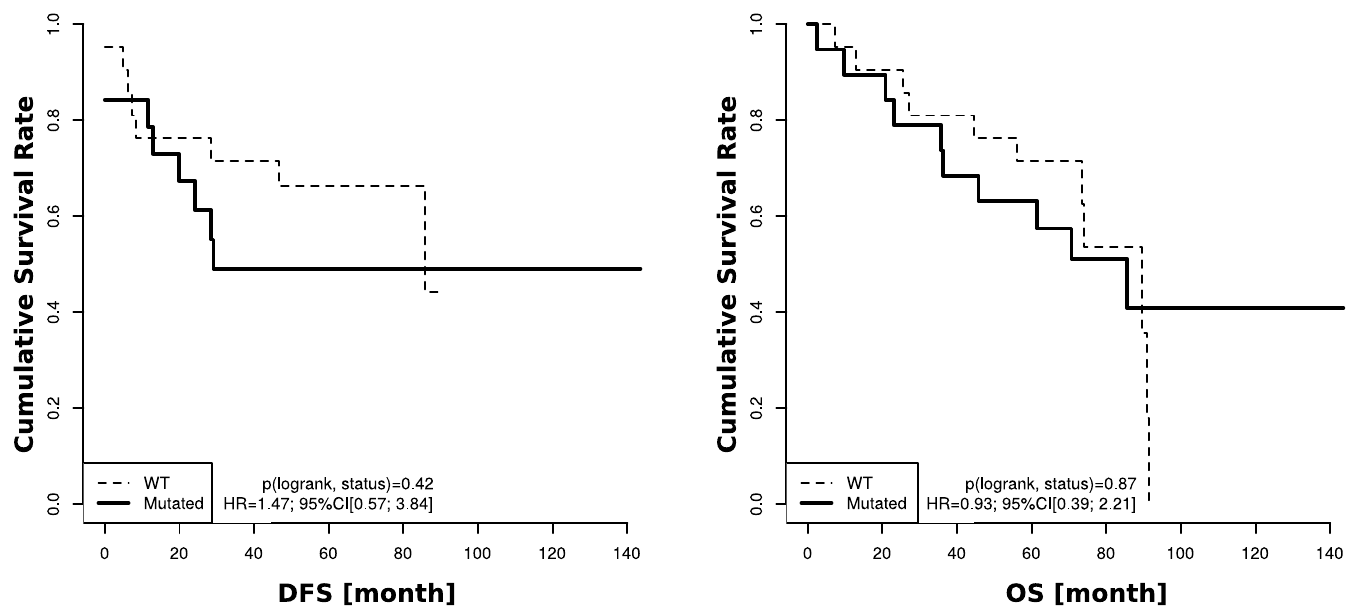
Fig 1. Caplan-meier curves for DFS and OS. DFS and OS Data was available for 40 patients ( KRAS mutated n = 19, KRAS wild-type n = 21). No significant correlation between KRAS mutated and wild-type patients was found for DFS and OS.